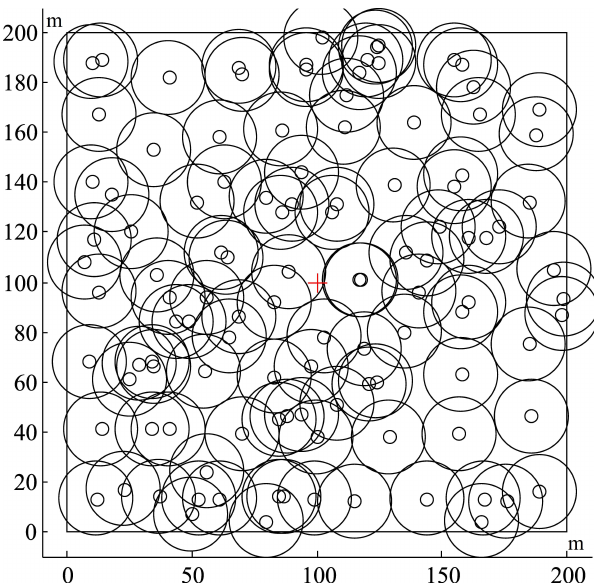
Figure 6. Senerio of SN and RN deployment within 200 × 200 m 2